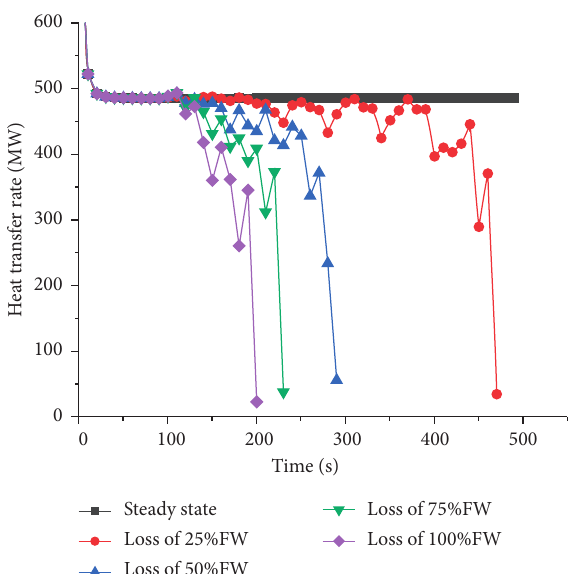
Figure 2: Changes in heat transfer rate at selected transient conditions.